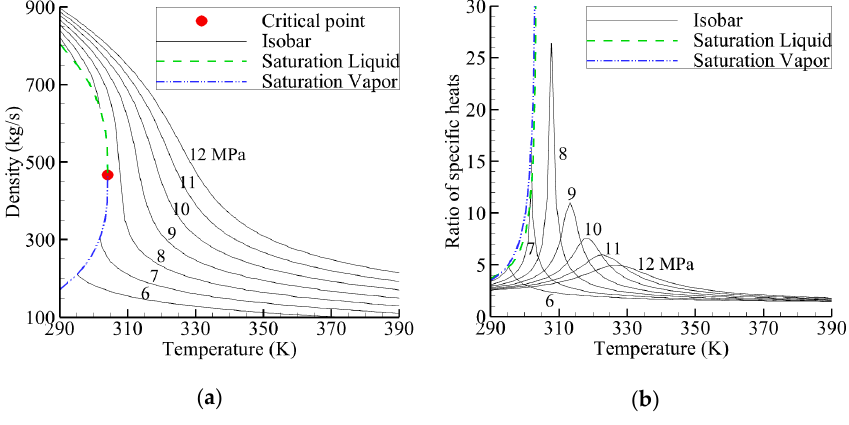
Figure 1. Thermodynamic properties of CO 2 versus temperature under different pressure: ( a ) Density; ( b ) Ratio of specific heats.